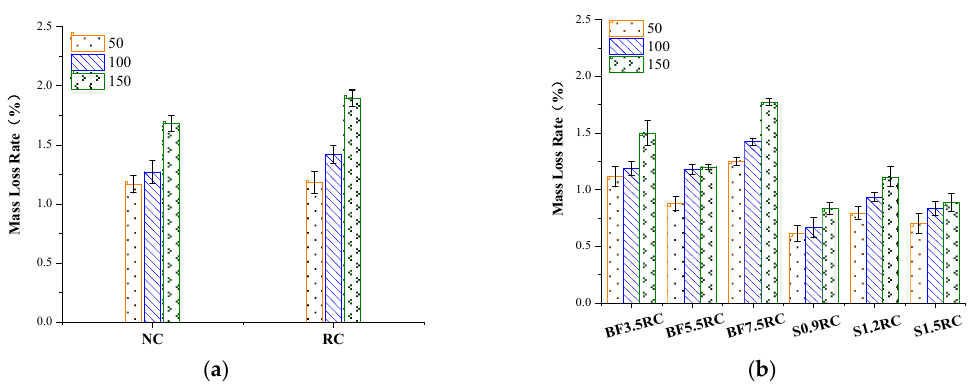
Figure 2. ( a , b ) The change in mass loss rate during freeze–thaw cycles. ( a ) NC and RC. ( b ) Steel fiber recycled concrete and basalt fiber recycled concrete.